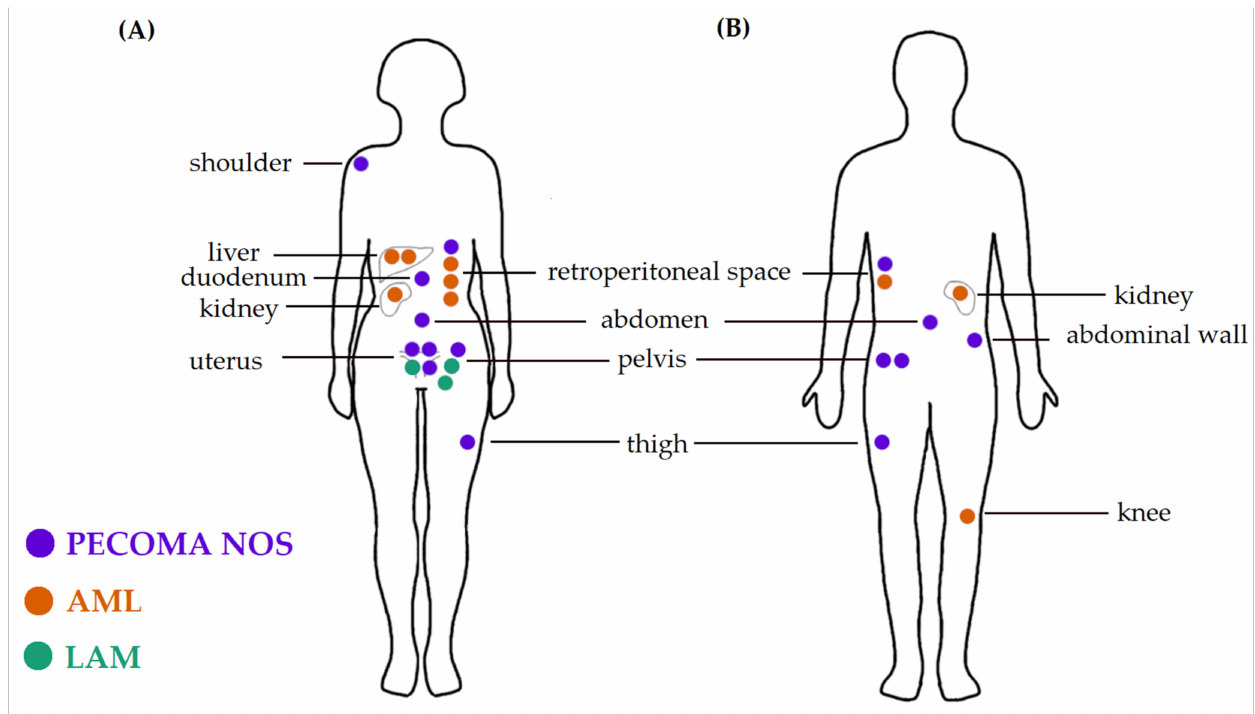
Figure 2. Graphical representation of anatomic localizations of primary tumors in female ( A ) and male ( B ) patients. Figure by Aleksandra